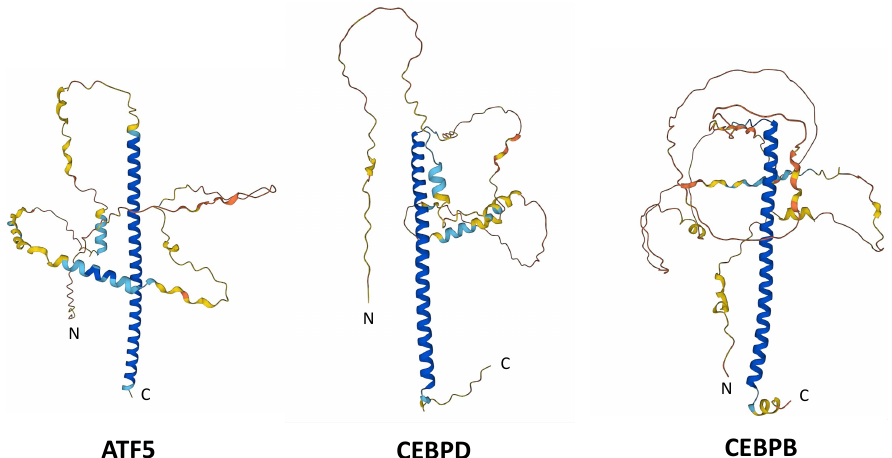
Figure 1. Structures of human ATF5, CEBPD and CEBPD as predicted by AlphaFold [8,9]. The N- and C-termini are indicated. The bZIP domains appear as the vertical coils in blue.